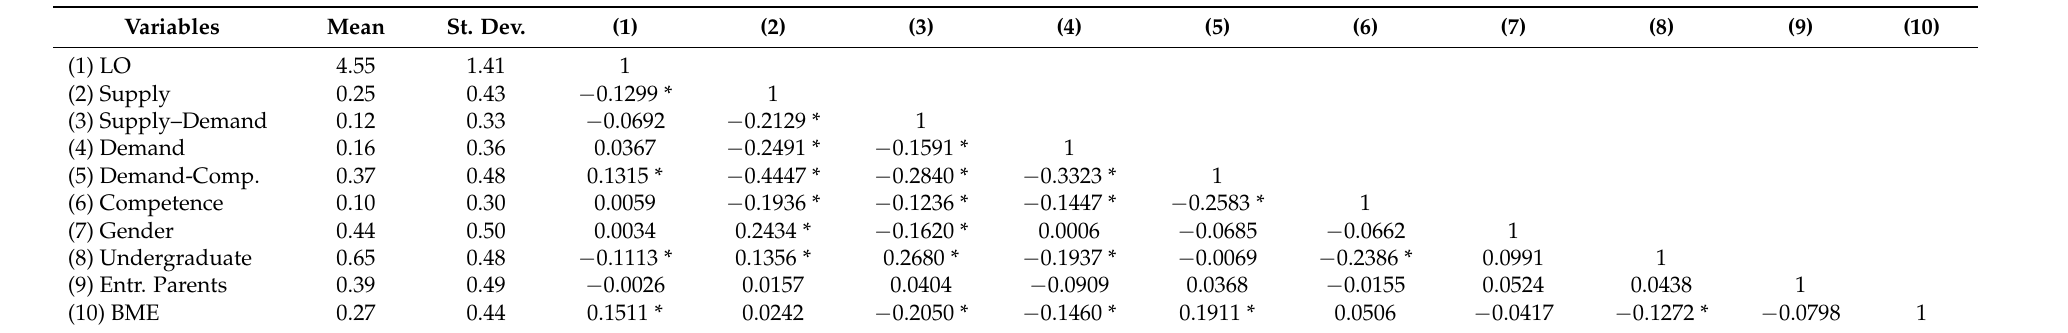
Table 7. Descriptive statistics and correlations.